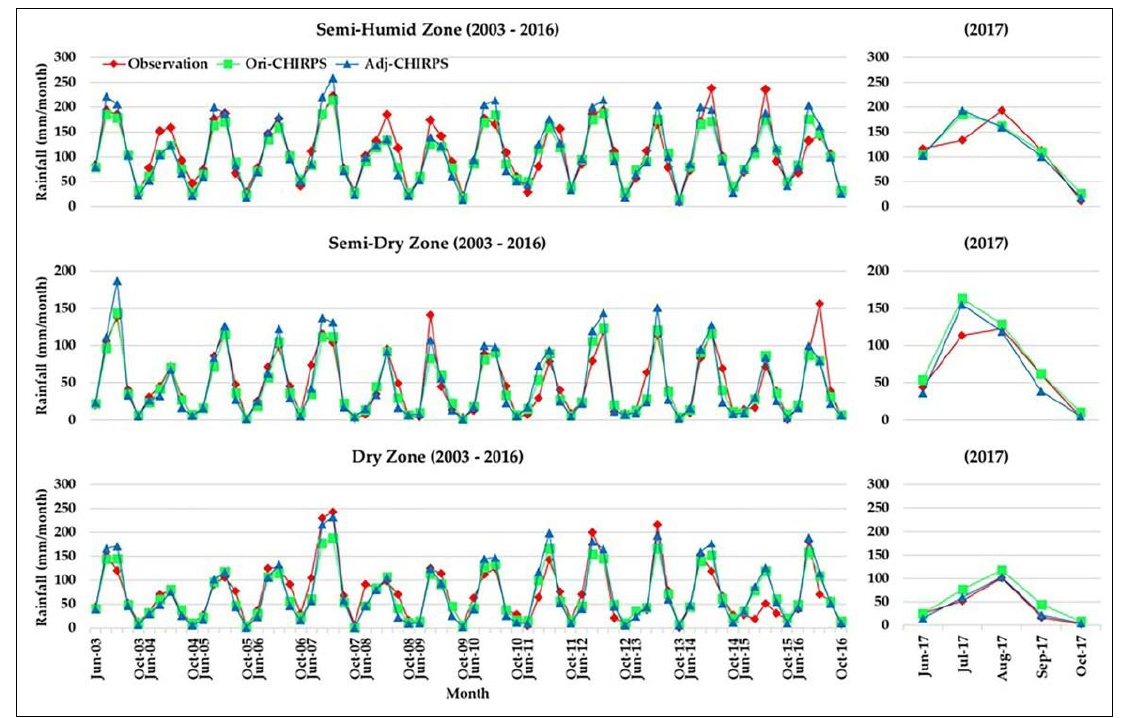
Figure 7. The areal mean monthly rainfall series for gauge observation, Ori-CHIRPS, and Adj-CHIRPS.